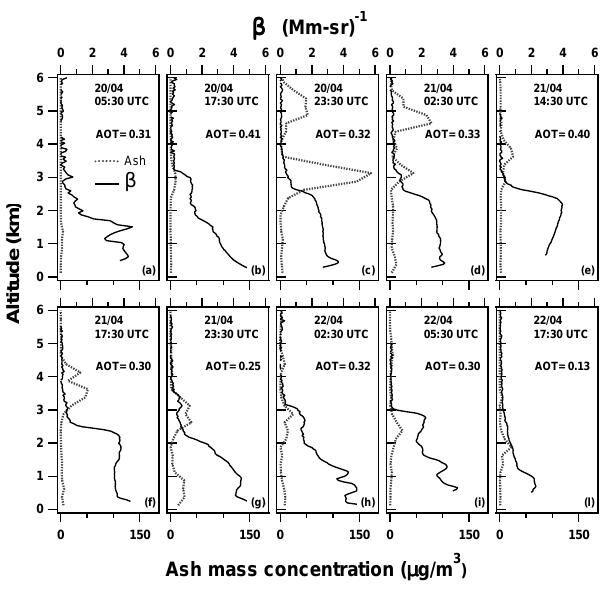
Fig. 3. Vertical profiles of the aerosol backscatter coefficient at 355nm (solid line) and of the volcanic ash mass concentration sim- Figure 3 (M. R. Perrone et al.) ulated by FLEXPART (dotted line) at different hours on 20, 21, and 22 April 2010.